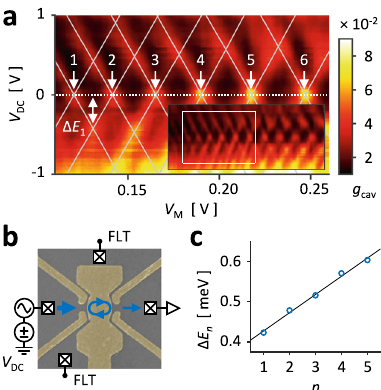
Fig. 4 | Transverse mode detuning. a Cavity deformation from δ V = V u (cid:1) V d breaks the re fl ection symmetry across the cavity axis while maintaining the mean cavity length, introducing a major perturbation between the transverse modes while minimally affecting the longitudinal modes. b Transverse mode detuning observed from g cav measured in con fi guration 2a as a function of δ V , mirror conductancessetto g 1,2 =0 : 6at δ V =0V.Twotransversemodeswereidenti fi edby their opposite evolution with respect to δ V : one marked in red and the other marked in blue. c The dominant resonance undergoes a transition as a function of the electron wavelength.